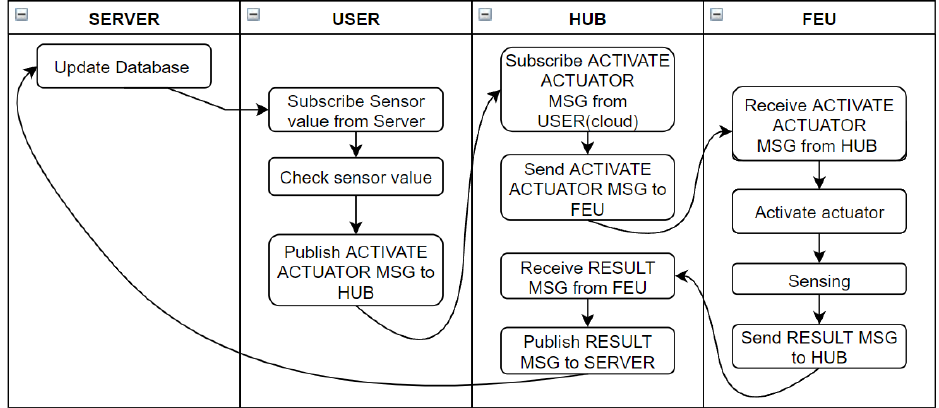
Figure 11. Schematic diagram of closed-loop control when the system determines actuator action at the cloud level.